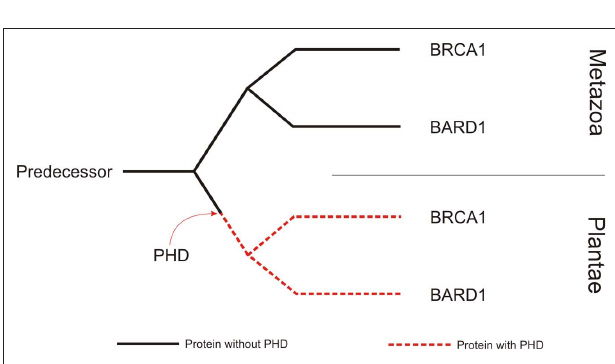
FiguRe 3 | Model of the evolution of BRCA1 and BARD1 in animals and plants. We propose that there was a single predecessor for the animal and plant BRCA1 and BARD1 genes. After the division of the animal and plant kingdoms, the single plant gene acquired a PHD domain. Afterward, there must have been an independent duplication of the plant and animal proteins, leading to BRCA1 and BARD1 in both kingdoms. Because the plant gene already had a PHD prior to its duplication, we can find that domain in all BRCA1 and BARD1